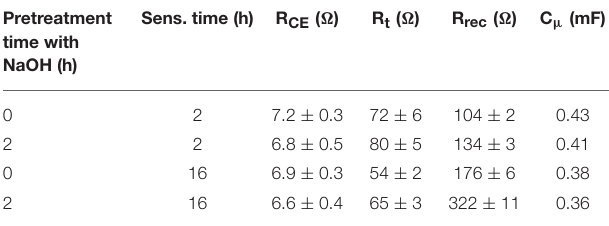
TABLE 4 | Parameters of VG21-C12-sensitized (un)treated NiO-based DSCs obtained from the fitting of the impedance spectra reported in Figure 5 . Pretreatment time with